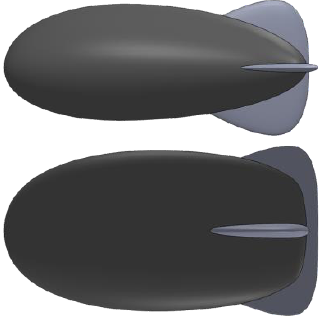
Figure 2. ATAA blimp shaped.